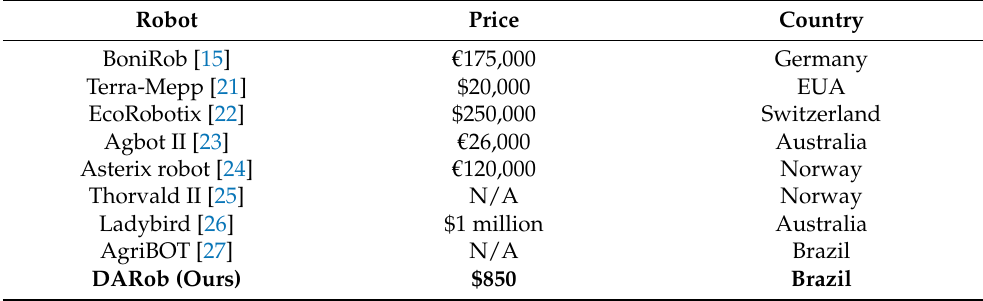
Table 2. Prices and places of origin of some common agricultural robots described in the literature.